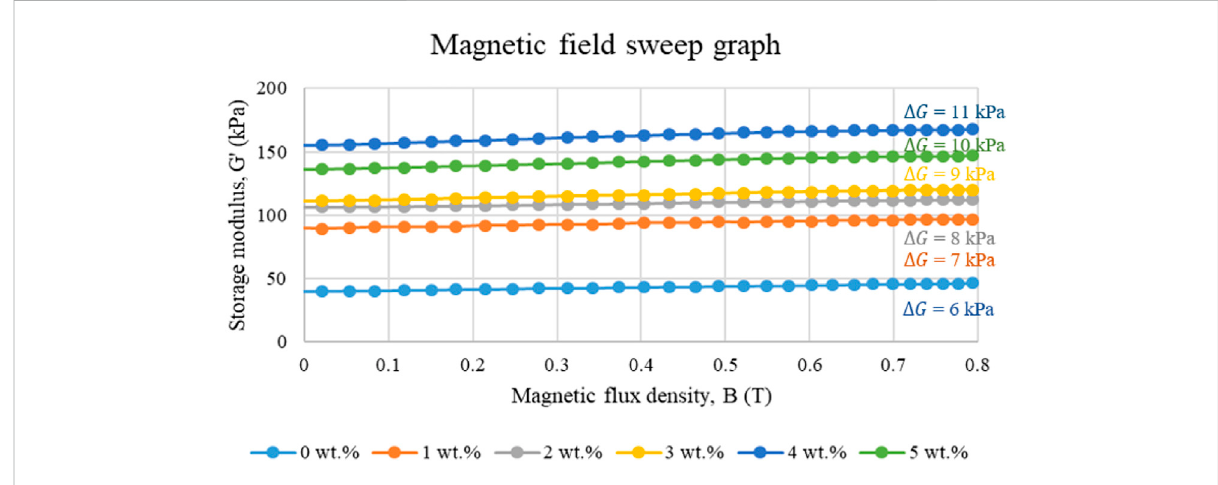
FIGURE 3 Change of storage modulus, G ′ , of MR foams with different composition of silica nanoparticles under the in fl uence of different magnetic fl ux density,